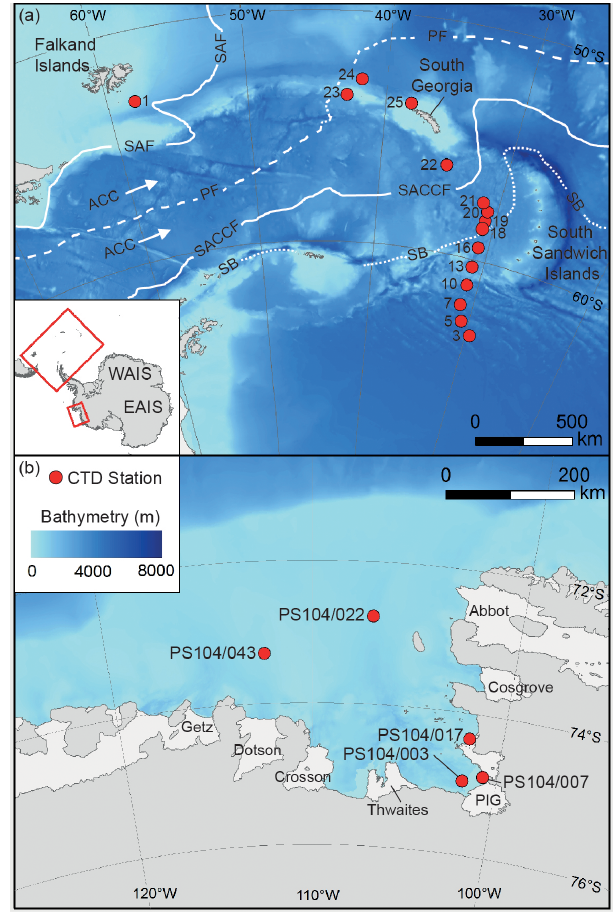
Figure 1. Map showing studied CTD sampling stations (red dots) in the Scotia Sea (a) and Amundsen Sea (b) . The main oceanic fronts are also shown in panel (a) : sub-Antarctic front (SAF), po- lar front (PF), southern ACC (SACCF), and the southern boundary of the ACC (SB) (Sokolov and Rintoul, 2009). The names of the ice shelves are shown in panel (b)